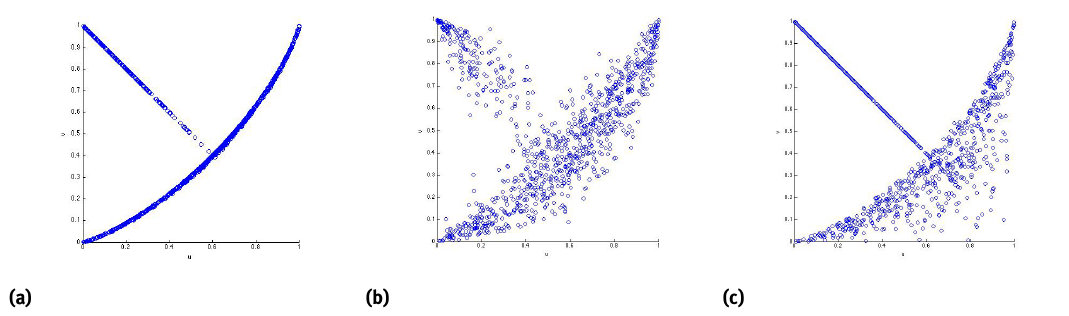
Figure 1: The Reflection Brownian Copula C ref , h and some of its extensions at time t = 1 with h = 2 . Figure 1a is the Reflection Brownian Copula. Figure 1b is the extension considering a Brownian motion correlated to the reflection of the first Brownian with a correlation ρ = 0.95 , which is the copula of Proposition 3. Figure 1c is the extension in the case of a random barrier following an exponential law with parameter λ = 2 , which is the copula of Example